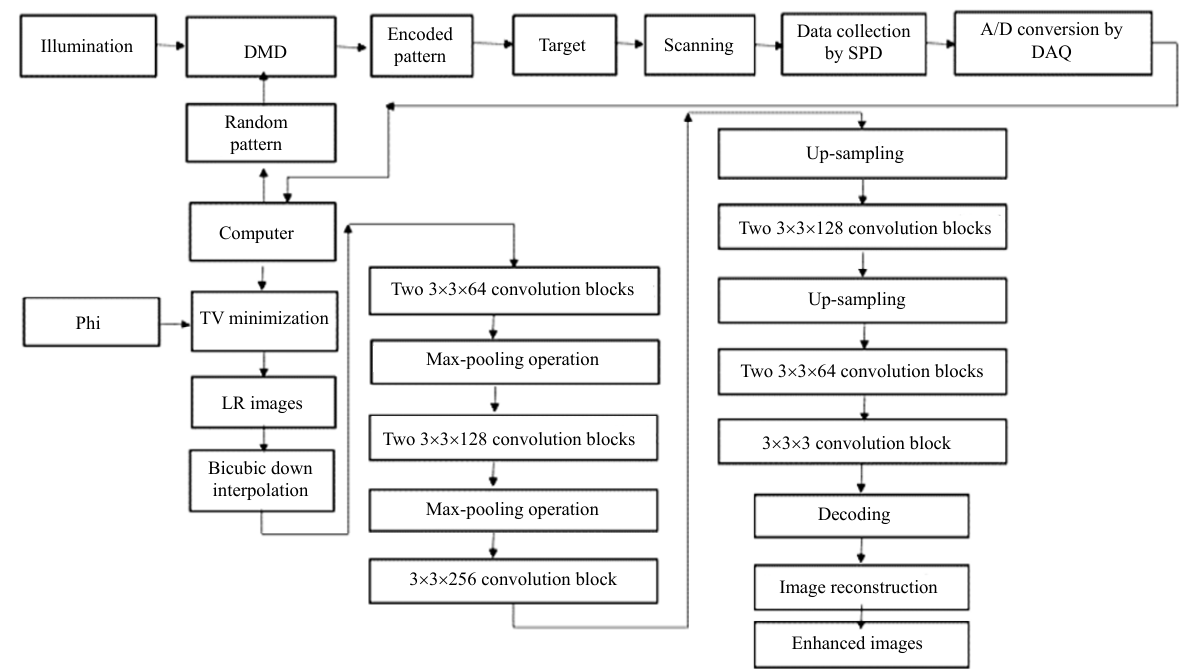
Fig. 5 Block diagram illustrating the process of data acquisition and image reconstruction based on the proposed CS-SRCNN